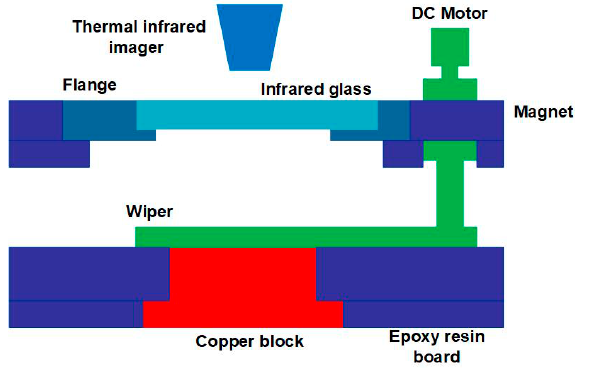
Figure 2. Schematic diagram of the condensation chamber.